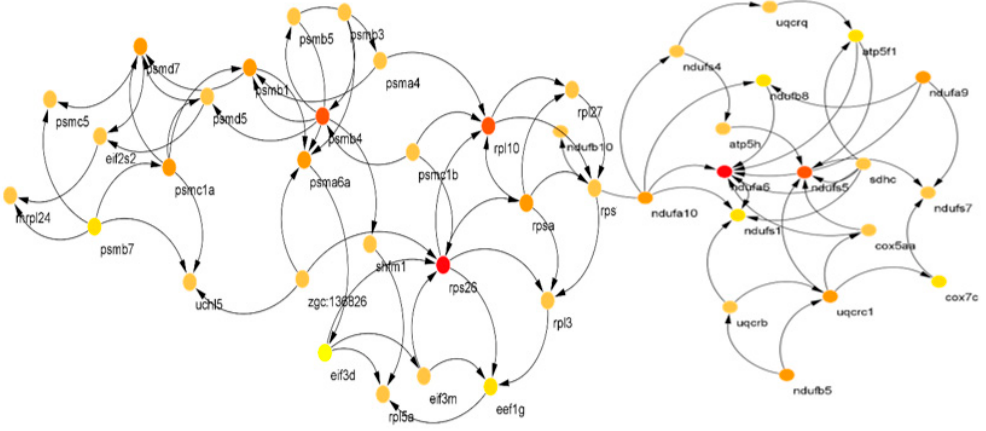
Figure 5. Identified causative genes (red, yellow and orange circles) from reconstructed Bayesian network of genes within Module 1 (right) and Module 2 (left) of the PPI network in Figure 4. Only connected genes are shown.